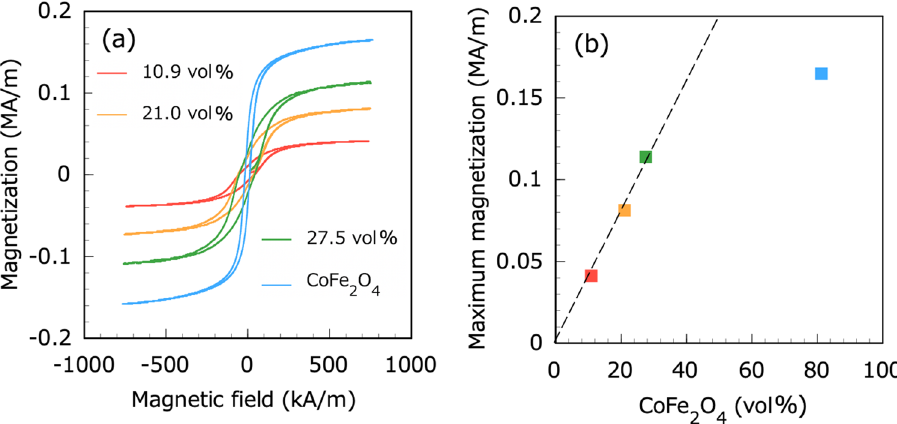
Figure 6. Magnetic properties of the CNF–CoFe 2 O 4 composite papers and CoFe 2 O 4 plate: ( a ) magnetization versus magnetic field curve and ( b ) plot of maximum magnetization versus CoFe 2 O 4 volume